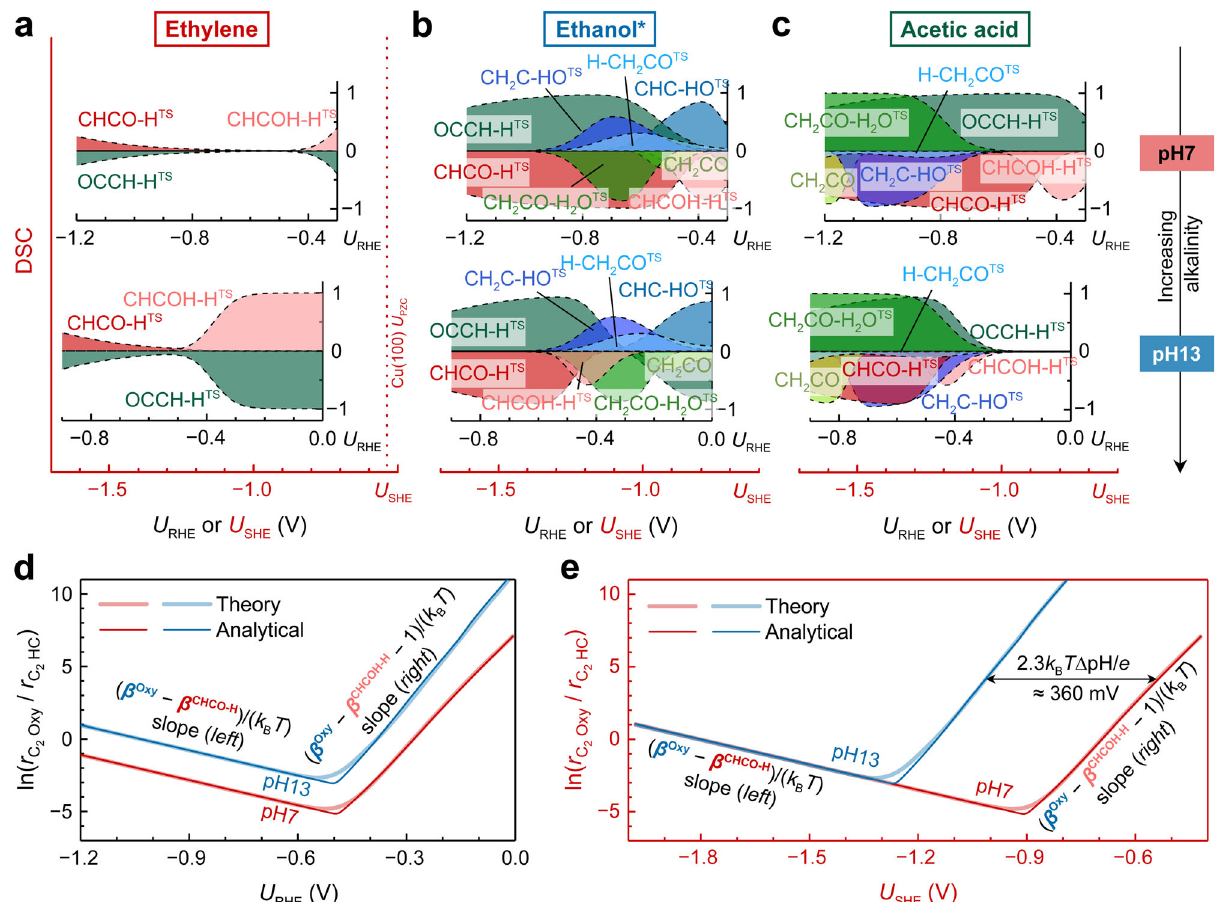
Fig. 4 Origin of the pH effects on the C 2 Oxy/HC selectivity for COR. Analyses of DSC for a ethylene, b ethanol + acetaldehyde (denoted as ethanol*), and c acetic acid. Similar to the degree of rate control conceptualized by Campbell et al. 60 , DSC serves as a powerful tool to quantify the magnitude of selectivity controlling by a certain intermediate or a TS. A positive (negative) value of DSC indicates that the corresponding reaction intermediate or TS needs to be stabilized (destabilized) in order to enhance the selectivity. The boundary values of 1 and − 1 represent full selectivity control by the intermediates. Only the energy states having signi fi cant contribution to the DSC, i.e. absolute value of DSC > 0.01, are shown. Key intermediates and TSs associated with the CHCOH, OCHCH, and CH 2 CO pathways are shown in reddish, bluish, and greenish colors, respectively. From the upper to lower r C2Oxy Þ as a function of d U U panels, the pH of bulk electrolyte increases from 7 to 13. Analytical approximation of ln ð RHE and e SHE at pH7 and pH13, in r C2HC comparison with the theoretical results obtained through microkinetic modeling. The slopes of the two legs are given by Eq. (1) and Eq. (2), respectively. β Oxy could be either β OCCH-H or β CHC-HO depending on the dominant C β OCCH-H was employed for Cu(100). Source data 2 Oxy formation pathway. Here are provided as a Source Data fi